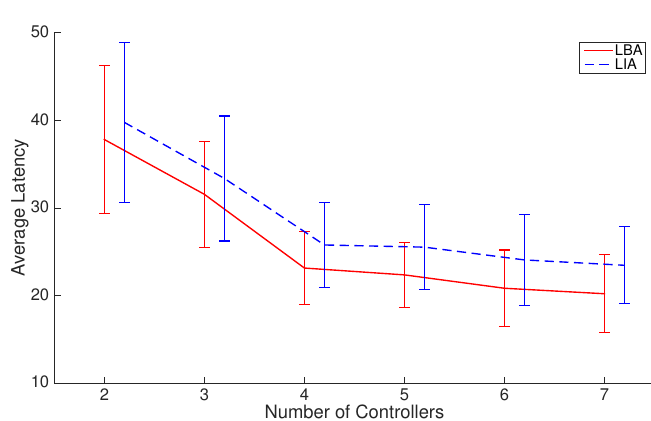
Figure 6. Average SFD-to-controller latency with different number of controllers.